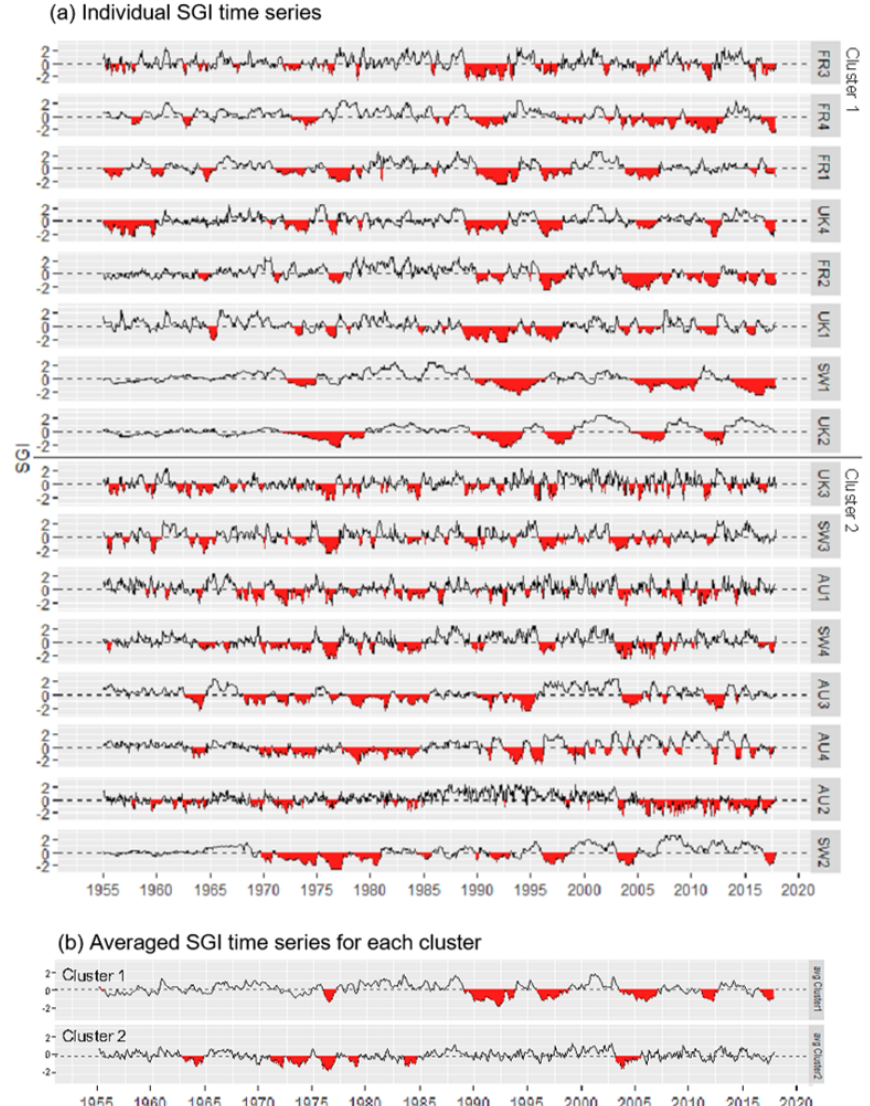
Figure 4. Combined graphic showing (a) the Standardized Groundwater level Index (SGI) for each site, and (b) the time series of calculated mean SGI values for each cluster, deriving from k -means